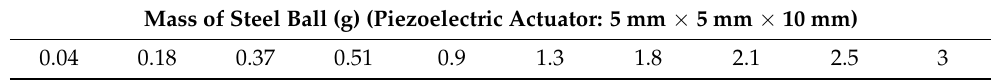
Table 3. Parameter table for the first set of experiments.